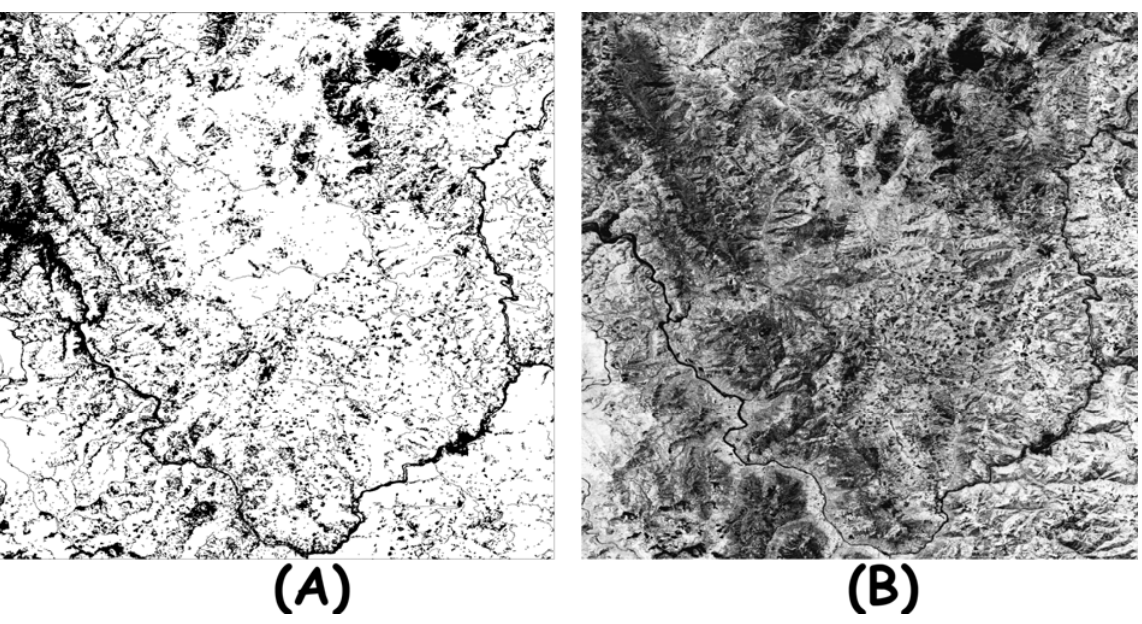
Figure 5. (a). The white points correspond to the evergreen forest class of the study area. (b) The sub-pixel percent tree canopy density of the study area (the lighter a pixel, the greater its canopy